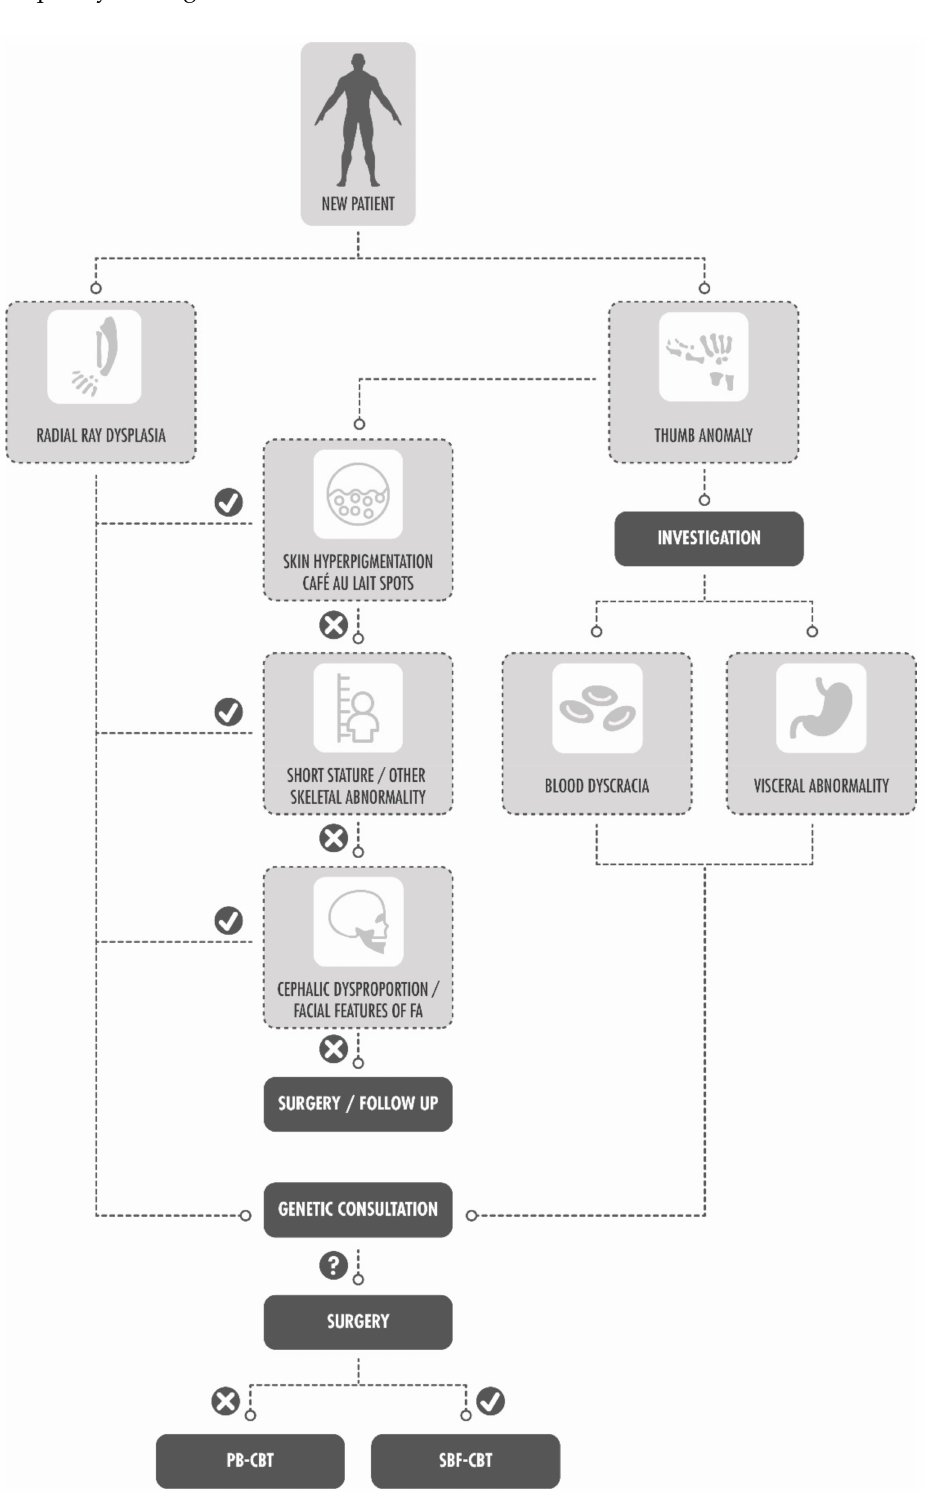
Figure 4. Algorithm for Fanconi anemia testing of patients with radial ray dysplasia or thumb anomalies presenting to the Congenital Hand Department at our hospital. PB-CBT = Peripheral Blood Chromosome Breakage Test. SBF-CBT = Skin Biopsy Fibroblast Chromosome Breakage